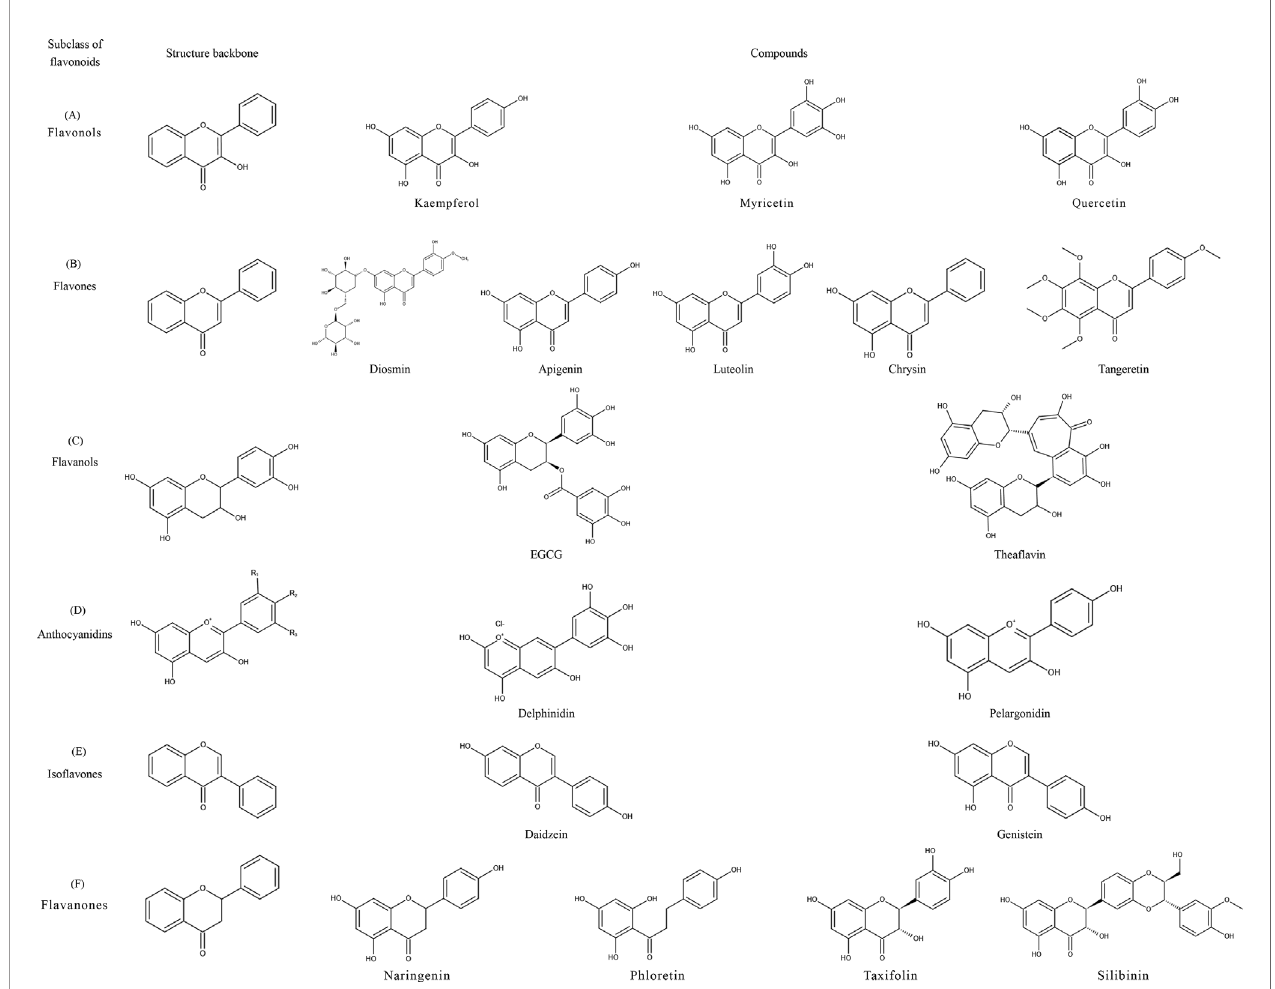
FIGURE 3 | Structural characteristics and representative compounds of six fl avonoids subclasses. C6-C3-C6 shows the core structure of fl avonoids with twobenzene rings linked to each other by three carbon atoms. After different modi fi cations, fl avonoids can occur in six subclasses with different characteristics: fl avonols, fl avones, iso fl avones, fl avanones, fl avanols, and anthocyanidins; structures are shown in the fi gure. (A) Flavonols: contain 3-hydroxyl fl avone analogs. (B) Flavones: the ketone of C4 in the C-ring is connected with C2-C3 by a double bond. (C) Flavanols: 3-hydroxy derivatives of fl avanones; the hydroxyl is located at the third position of the C-ring. (D) Anthocyanidins: glavylium cation binding hydroxyl and/or methoxy groups at the R, R, and R sites. (E) Iso fl avones: the B-ring is connected at C3 of the C-ring instead of C2. (F) Flavanones: contain fl avone analogs with a C2-C3 single bond